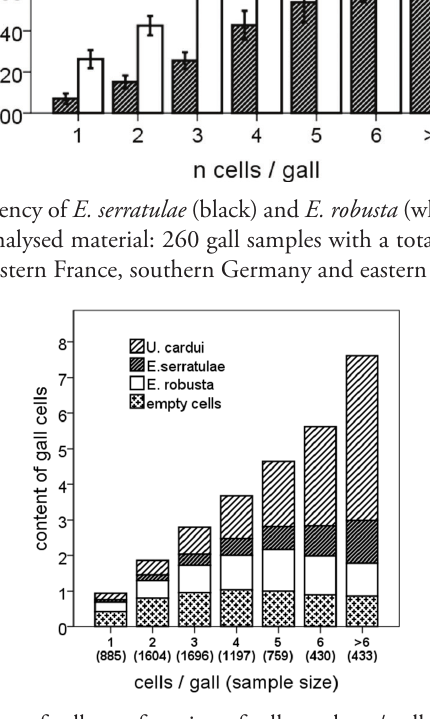
Figure 3. Average content of galls as a function of cell numbers / gall. (In parentheses: number of galls